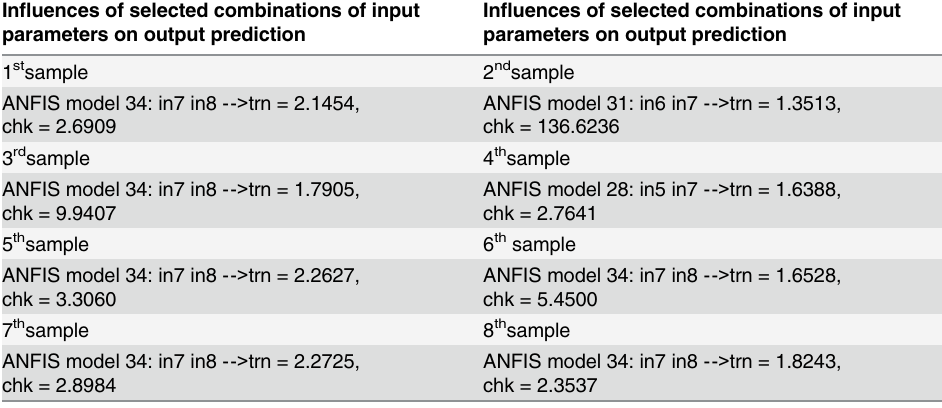
Table 5. Combinations of two input parameters for vehicleagent speed relative to vehicle intruder prediction. In fl uences of selected combinations of input parameters on output prediction